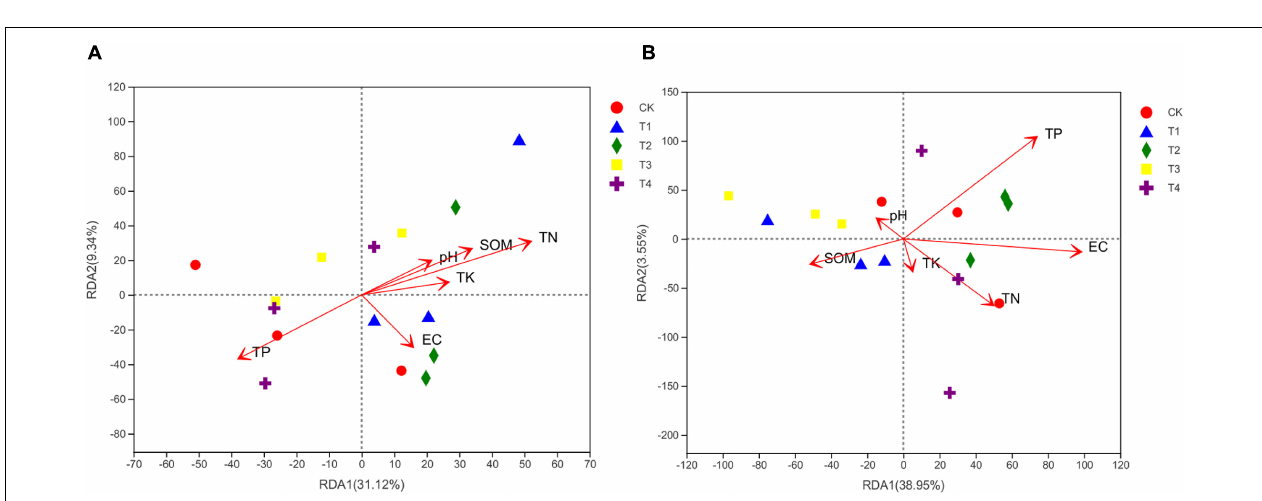
FIGURE 2 | Relative abundances of bacterial (A) and fungal (B) taxa at the phylum level. The relative abundances of bacteria (C) and fungi (D) were tested by the Kruskal–Wallis H -test. “Other” includes phyla with < 1% average relative abundance. Values for individual treatments are the means of three replicate soil samples. The false discovery rate was used to control for multiple tests, and the Scheffe test was used to calculate the 95% confidence intervals. CK, T1, T2, T3, and T4 are as defined in the Figure 1 legend.